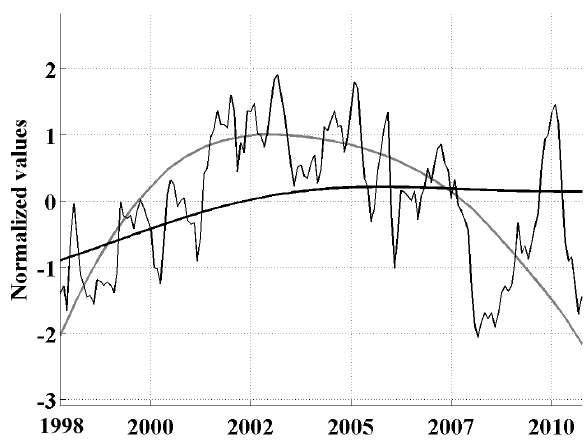
Figure 9. The Improved El Niño Modoki Index (IEMI) time series (thin black) and Principal Components 1 (PC1) time series (grey) for the L = 128 months extended empirical orthogonal function (EEOF) analysis. The bold black line is the IEMI smoothed at 128 months. All values are